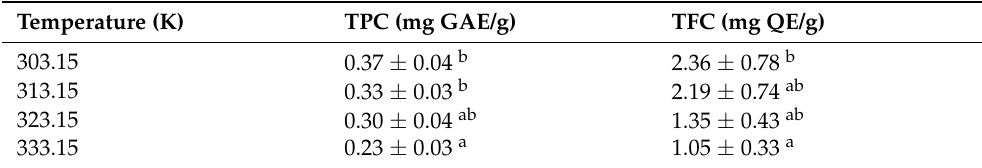
Table 6. Total phenolic and flavonoid contents of Kyoho skin as affected by drying temperature 1 . Temperature